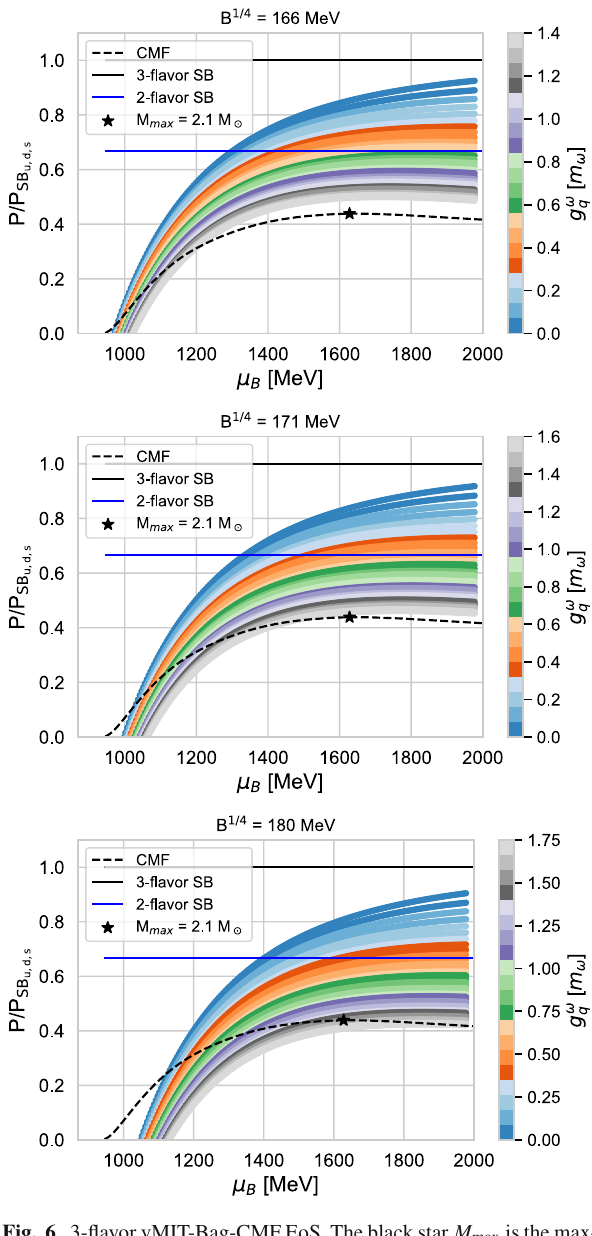
Fig. 6 3-flavor vMIT-Bag-CMF EoS. The black star M max is the max- imum mass of the pure CMF curve and the blue horizontal line is the two flavor Stefan–Boltzmann limit. Smaller values for B shift the tran- sition to smaller masses. This behaviour was also observed for the pure Bag model. Higher repulsion shifts the transition to a slightly higher chemical potential. It also changes the slope, higher values stiffen the